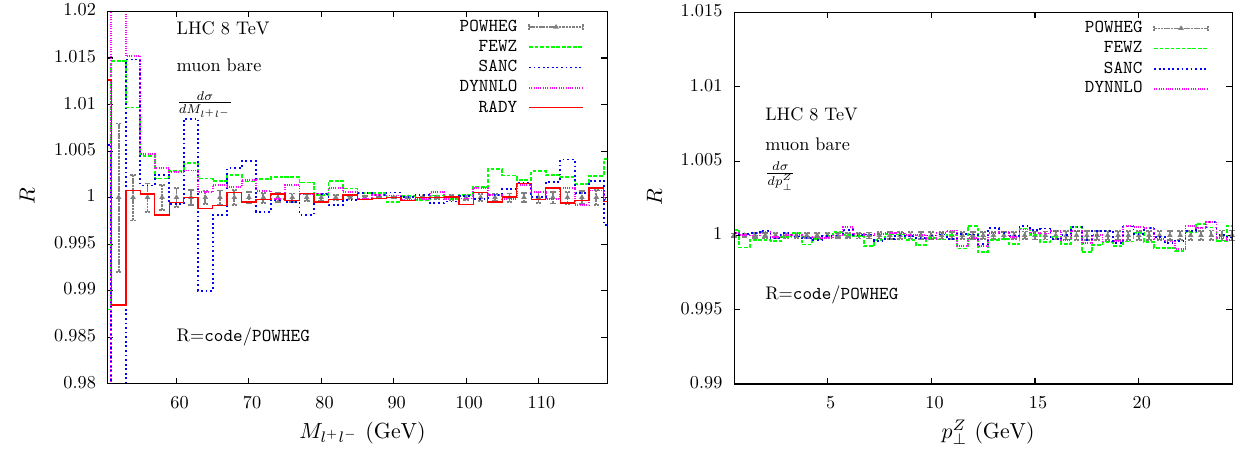
Fig. 13 Tuned comparison of the lepton-pair invariant mass and transverse momentum distributions in pp → γ, Z → μ + μ − + X at the 8 TeV LHC with ATLAS/CMS cuts in the bare setup, including NLO QCD